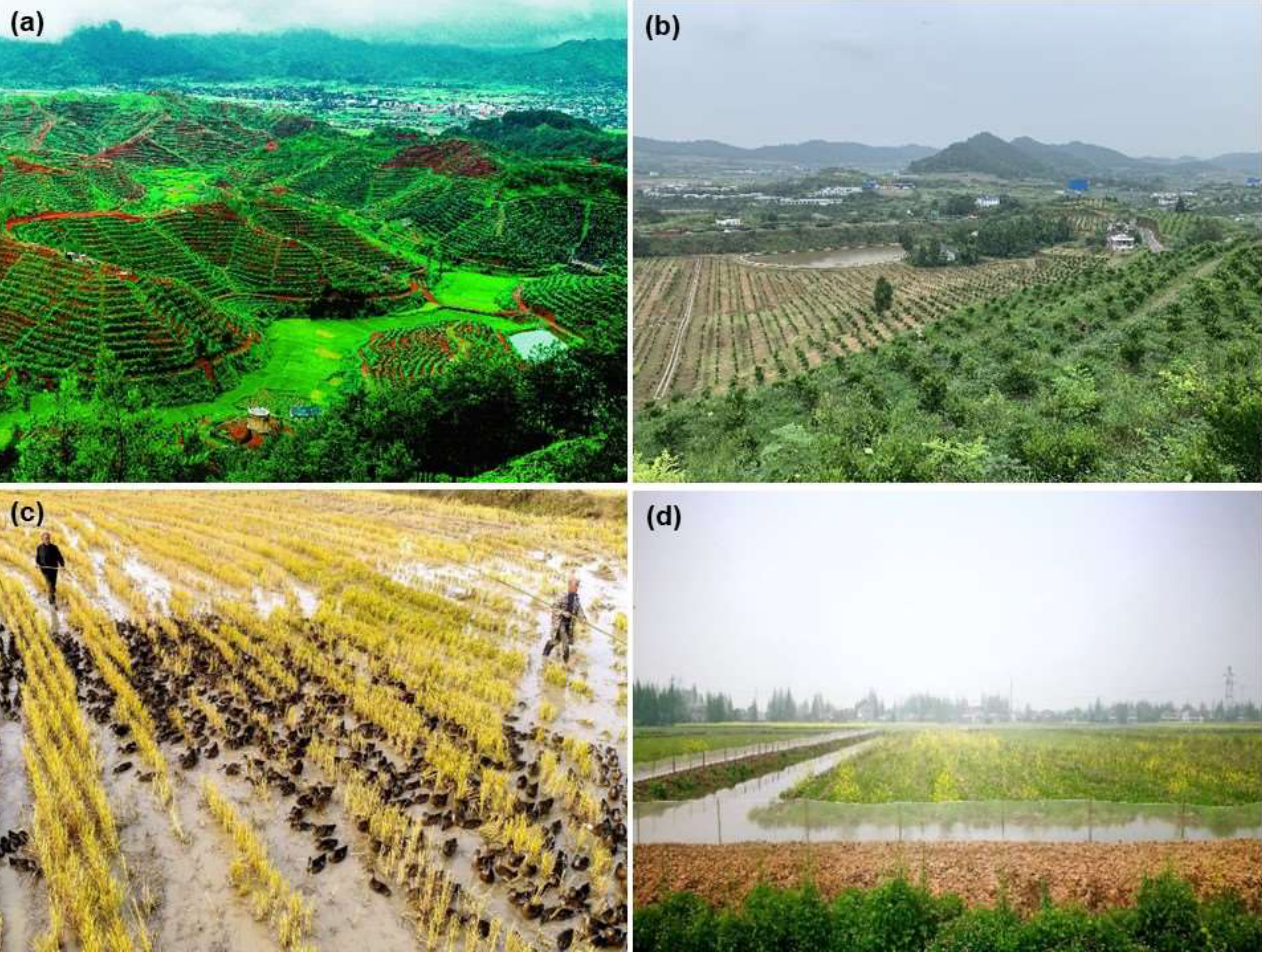
Figure 1. The ecological agriculture models in Southern China: pig raising–biogas production–navel orange ( a ) or citrus ( b ) plantation models in hilly regions, and duck-raising model ( c ) and crayfish culture model ( d ) in paddy fields.